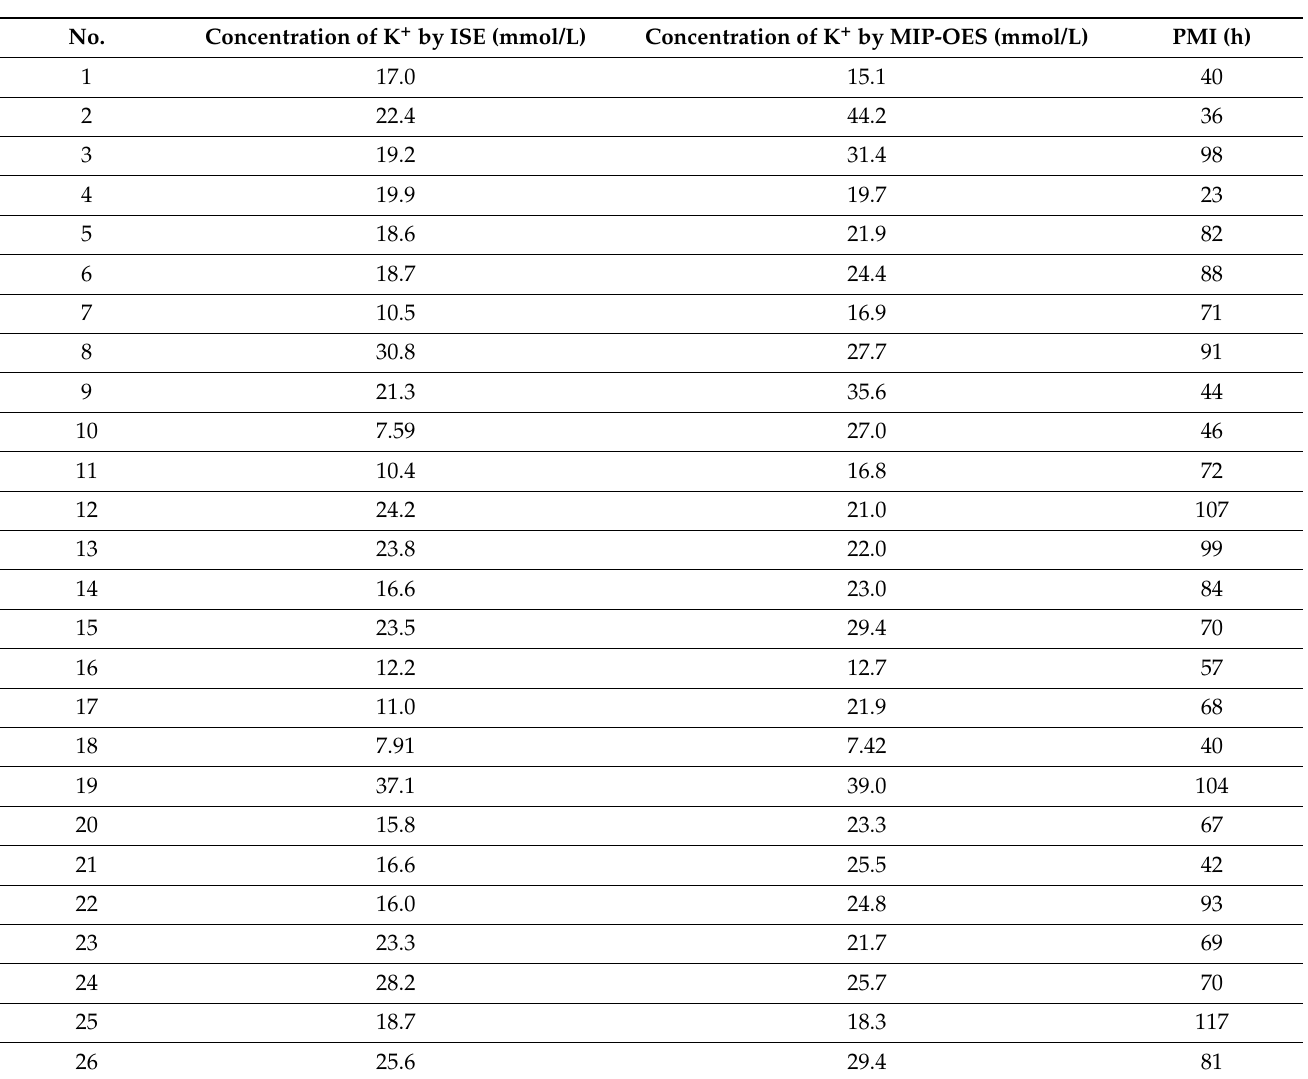
Table 9. Results of the PMI assessment (based on the data from Table 3) and the determination of potassium ion concentration in the VH using ISE and MIP-OES methods in 26 deceased